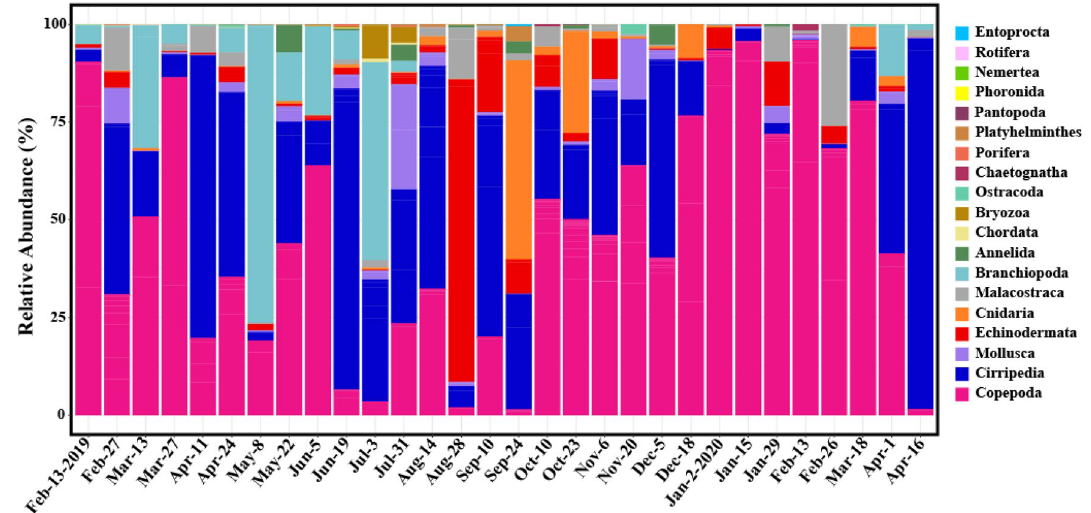
Figure 3. Taxonomic composition of zooplankton for 30 samples with 19 taxonomic groups. The bar heights are indicated proportion (percentage of reads) of each taxonomic group. Figures were produced using R (v4.0.3, https:// www.R- proje ct.